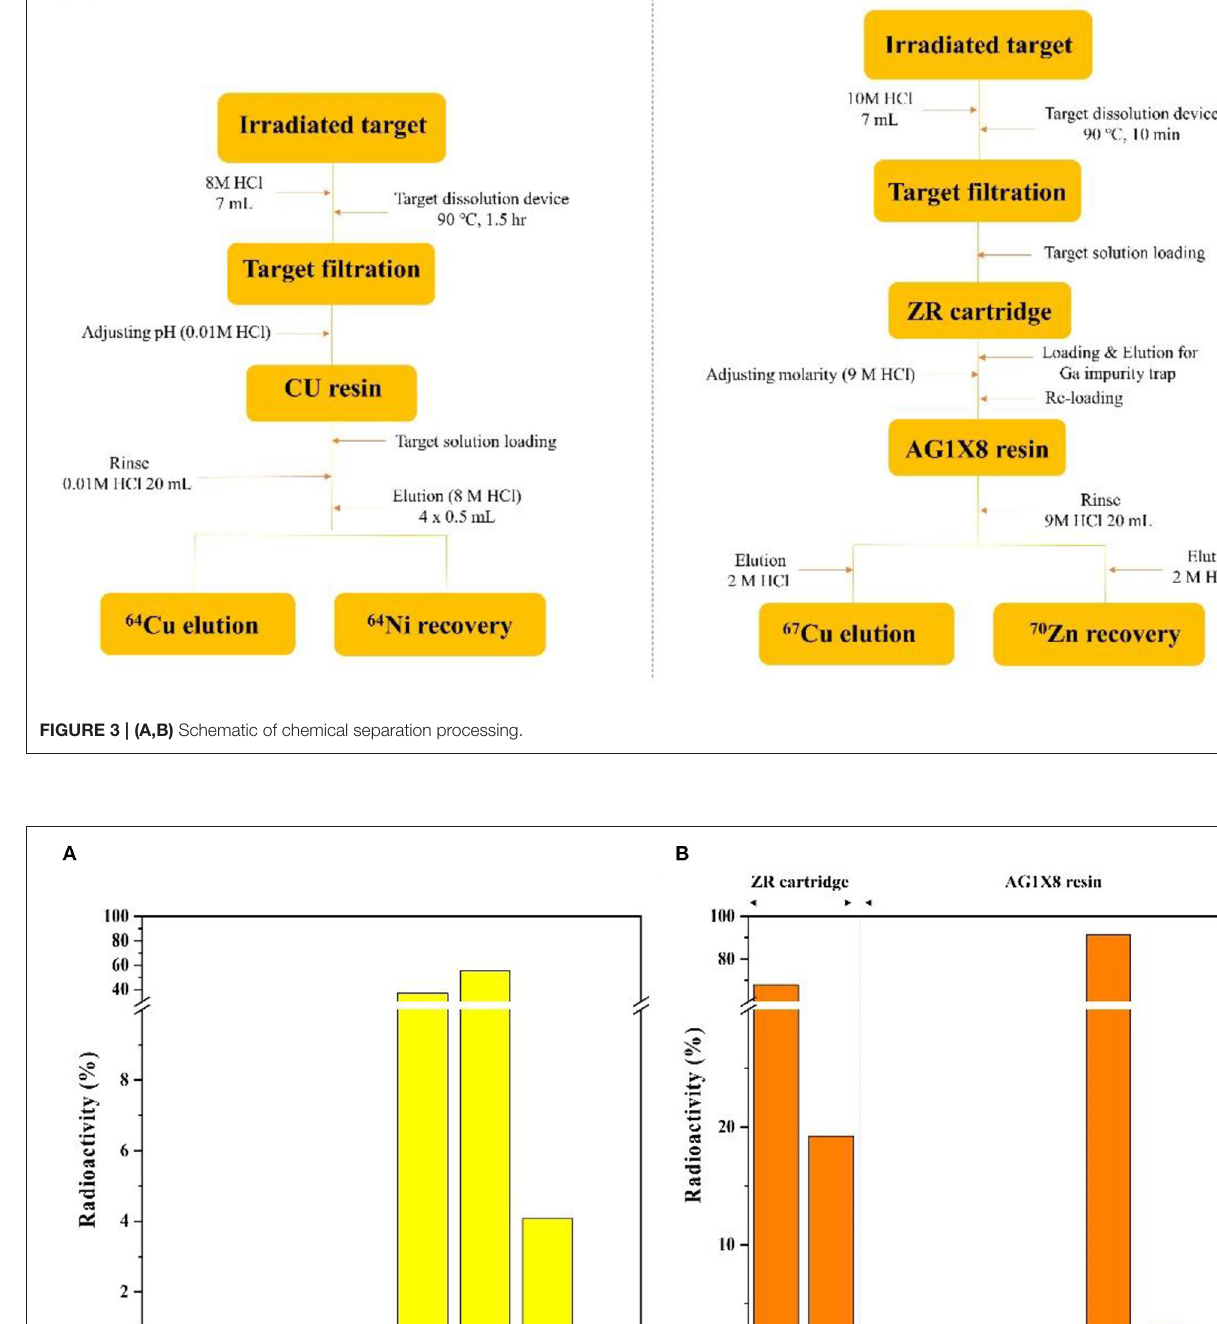
Frontiers in Medicine |